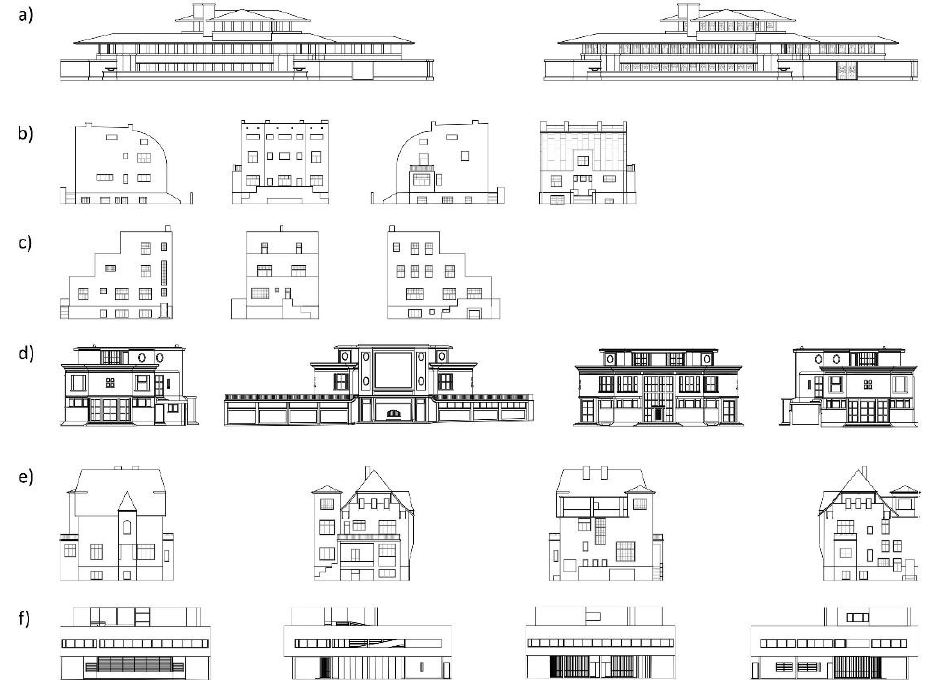
Figure 12. Analyzed buildings without scale: ( a ) Robie House, street view with and without window design, FL Wright, 1908, ( b ) House Steiner, north, east, south, west view, Loos, 1910, ( c ) House Scheu, north, east, south view, Loos, 1913, ( d ) Villa Schwob, north-east, north-west, southeast, south-west, Le Corbusier, 1916, ( e ) House Mandl, Loos, north, east, south, west view, 1916, ( f ) Villa Savoye, north, east, south, west view, Le Corbusier, 1928.